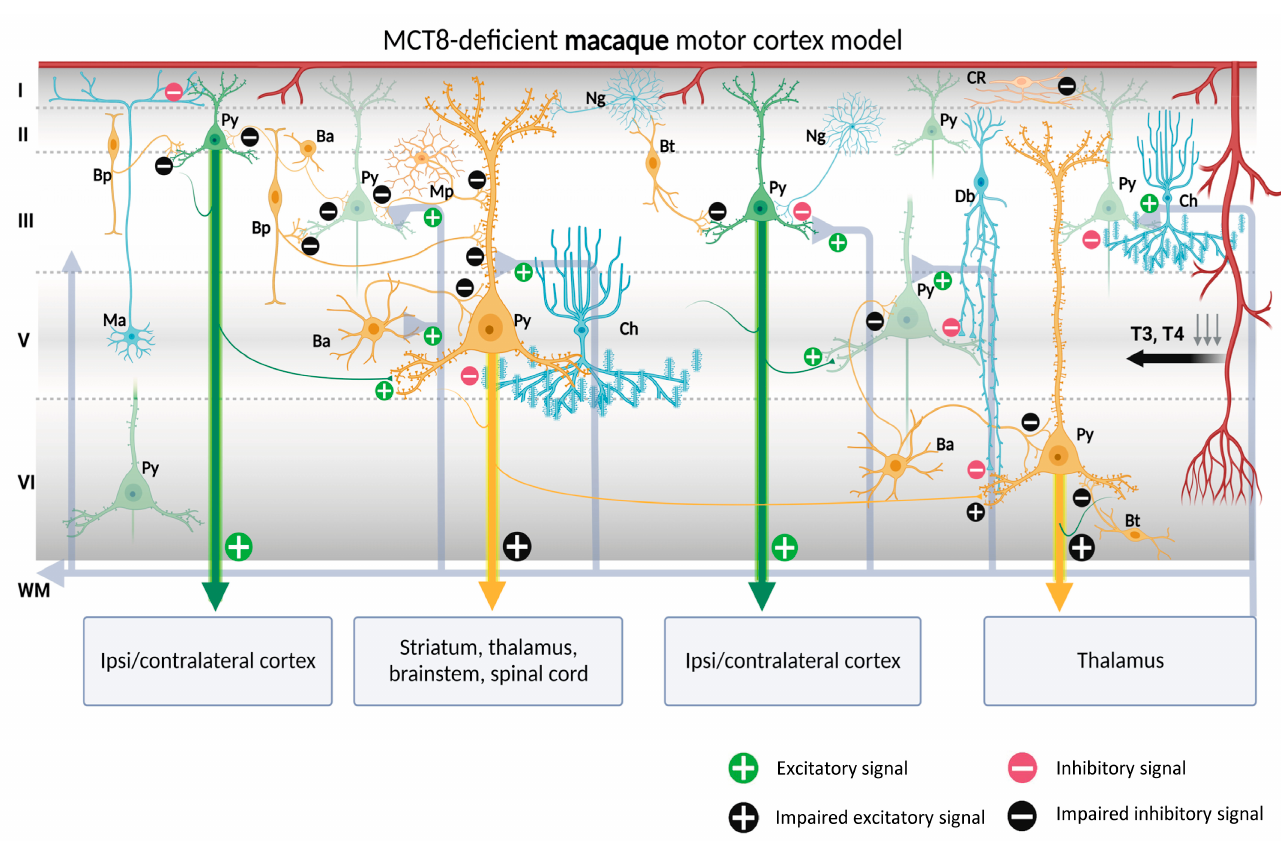
Figure 10. Models of human and macaque MCT8-deficient motor cortex. The models include our results and show possible cortical functional microcircuitry physiopathogenic mechanisms. A deficiency of MCT8, the most important route for circulating TH into the brain, results in a lack of TH throughout the brain. Pyramidal cells and interneurons expressing MCT8 are shown in yellow. Pyramidal cells non-expressing MCT8 are shown in green and interneurons non-expressing MCT8 are shown in blue. The lack of T3 and T4 may cause trophic deficits in pyramidal cells and interneurons, generating hyperexcitation on pyramidal cells due to the possible abnormal inhibitory function of the interneurons. Abnormalities in pyramidal cells may cause irregularities in their excitatory output signaling to intrinsic and extrinsic targets, producing symptoms such as spasticity, hyper- tonia, hyperreflexia, epilepsy, and others, depending on the final dendritic activity. Ba: basket cell, Bp: bipolar cell, Bt: bitufted cell, Ch: chandelier cell, CR, Cajal–Retzius cell, Db: double bouquet cell, Ma: Martinotti cell, Mp: multipolar cell, Ng: neurogliaform cell, Py: pyramidal cell, L I–VI: layers of the cerebral cortex, WM: white matter (scheme based on Szent á gothai, 1975 [139] and Jones, 1993 [140]; created with